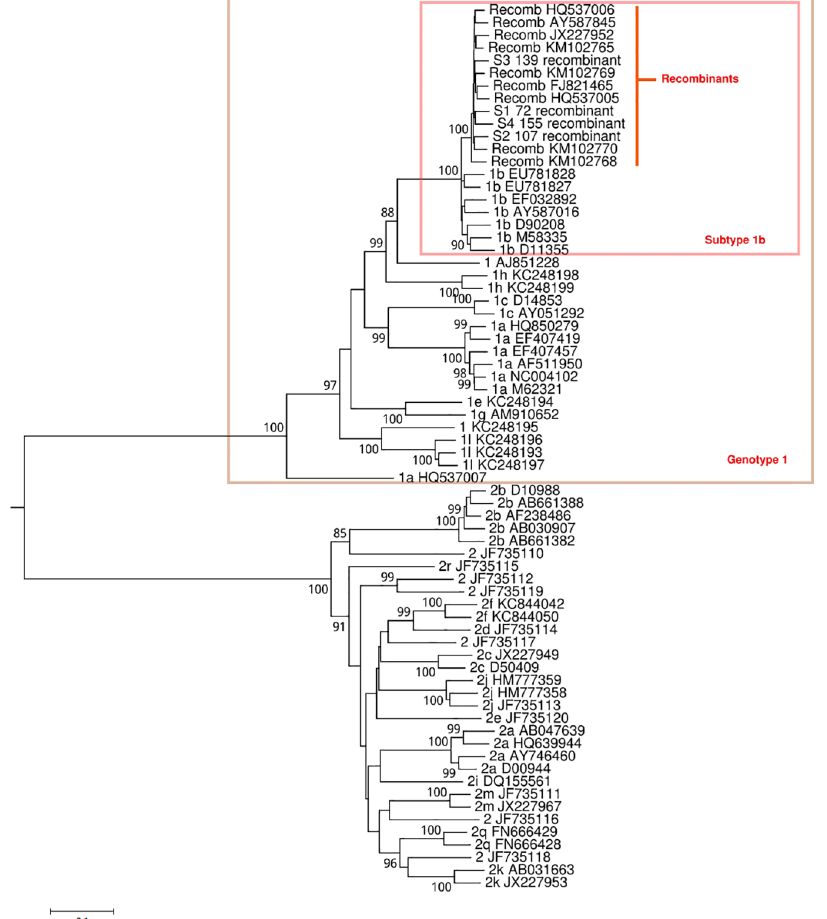
Fig 3. Phylogenetic analysis of the NS3 through NS5B genes. The Maximum Likelihood tree was constructed using MEGA 6.0 using the GTR model of evolution, incorporating assumed rate heterogeneity ( Γ